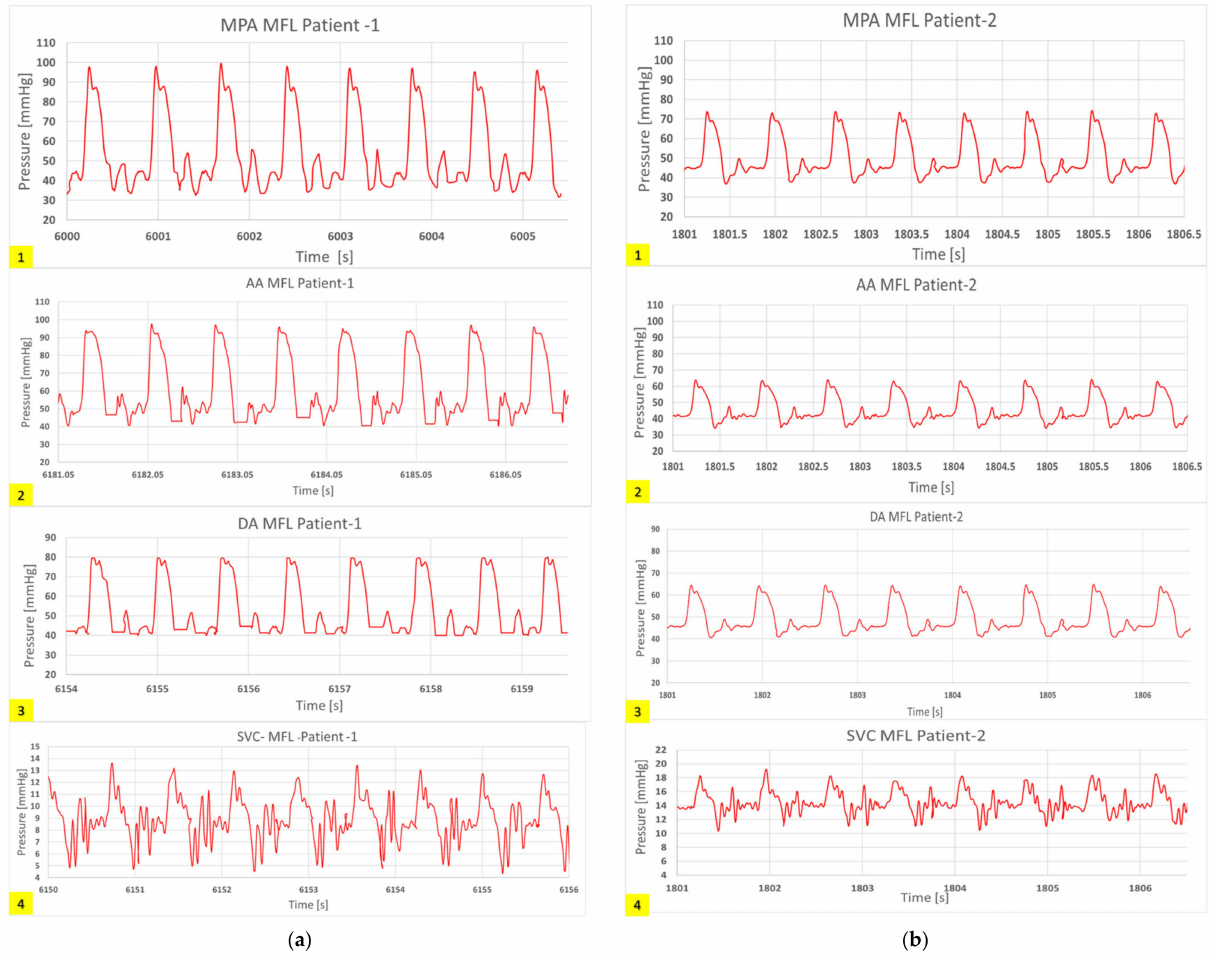
Figure 16. In-vitro results showing hemodynamic pressure waveforms (in mmHg) acquired at the following locations in the MFL are 1. MPA conduit in HCSII anatomy, 2. AA conduit in HCSII anatomy, 3. DA conduit in HCSII anatomy 4. SVC at the analogous BDG section, for ( a )